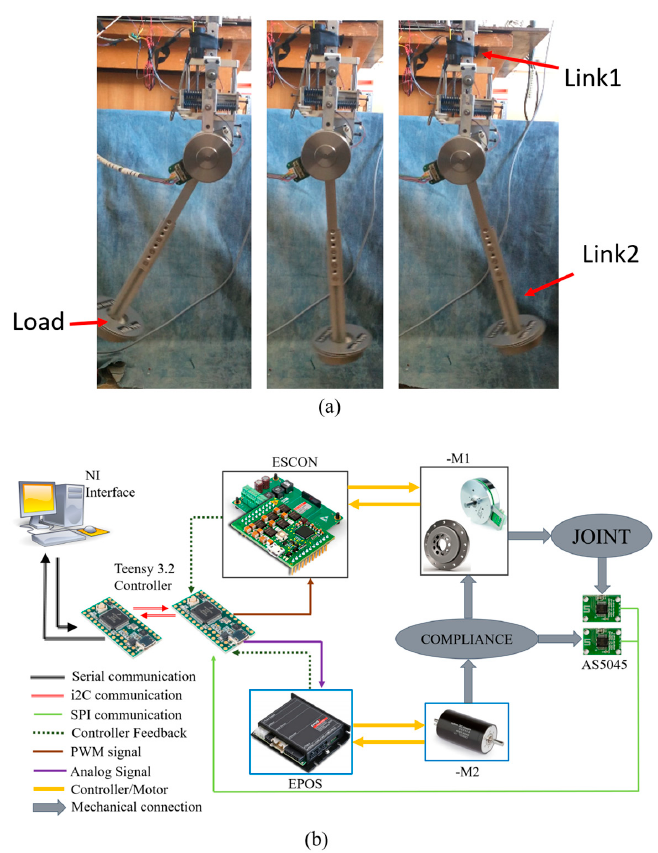
Figure 6. Experimental setup for the ARES-XL: ( a ) sequence of snaps of the ARES-XL test bench; ( b ) schematics of the data acquisition and control implemented in the evaluation of ARES-XL.